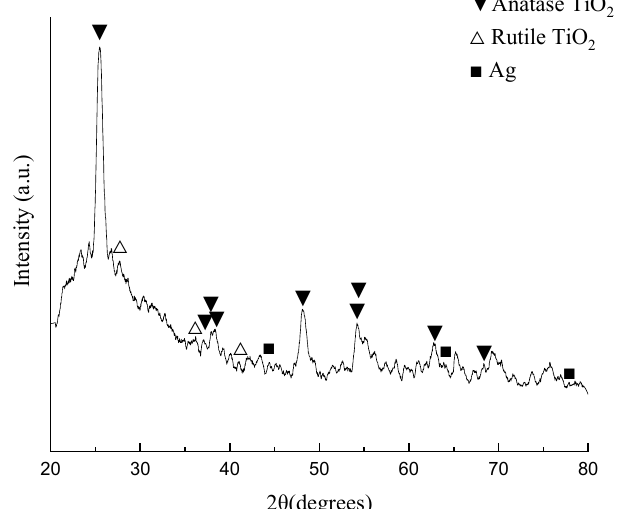
Figure 3. The XRD analysis of Ag / TiO 2 nanofibers.